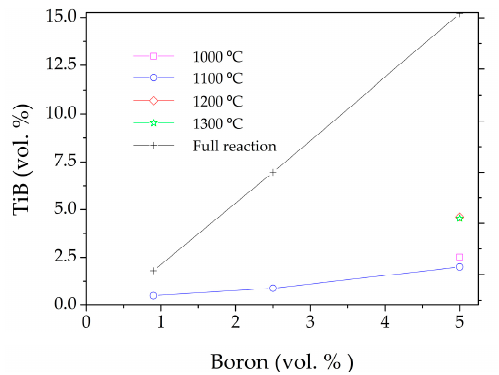
Figure 8. Volume percentage of TiB formed by full reaction Ti-B vs. volume percentage of Boron added as starting material.